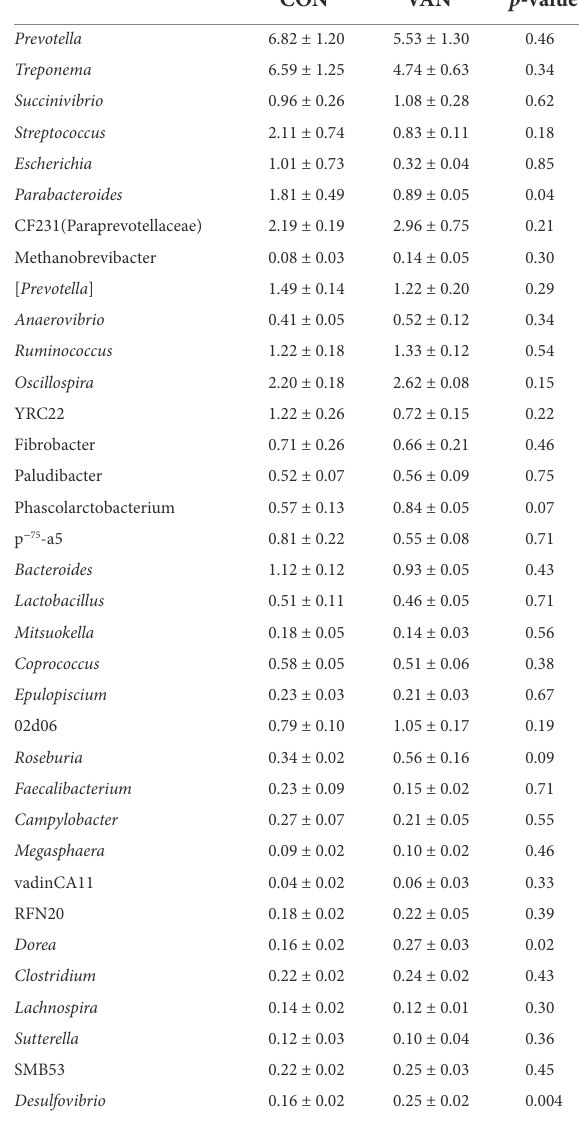
TABLE 3 Comparison of alpha metrics’ difference in control group (CON) and vancomycin group (VAN). Item